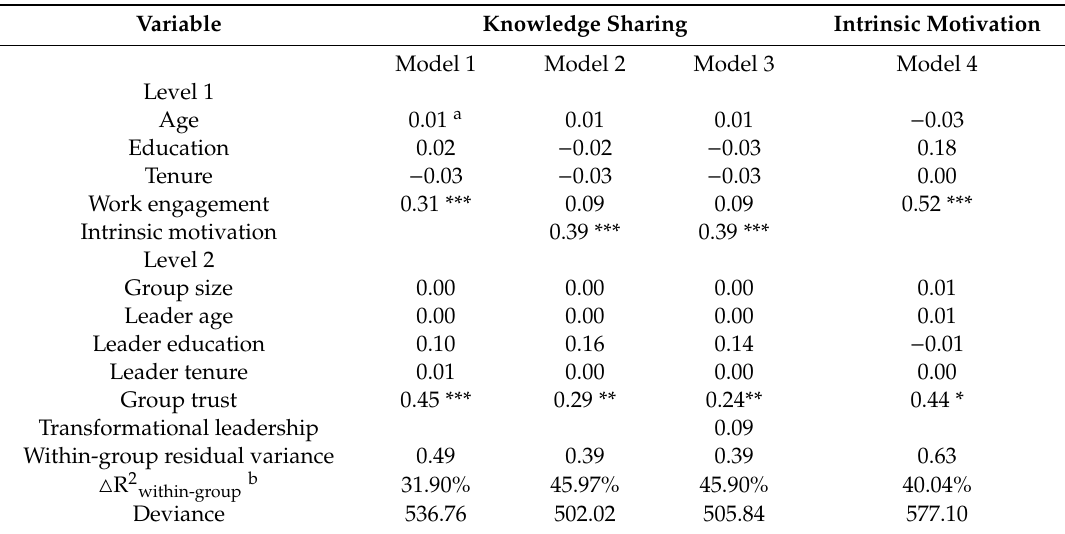
Table 2. Results of hierarchical linear modeling (HLM) analyses.